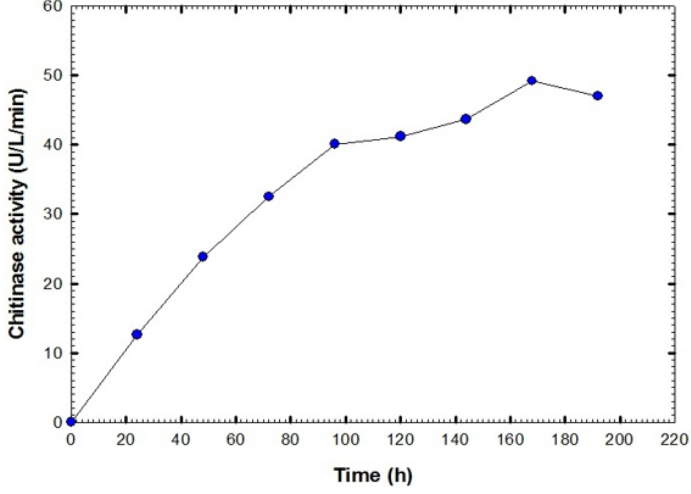
Figure 2. Chitinase activity of cell-free supernatant of Streptomyces cellulosae Actino 48.